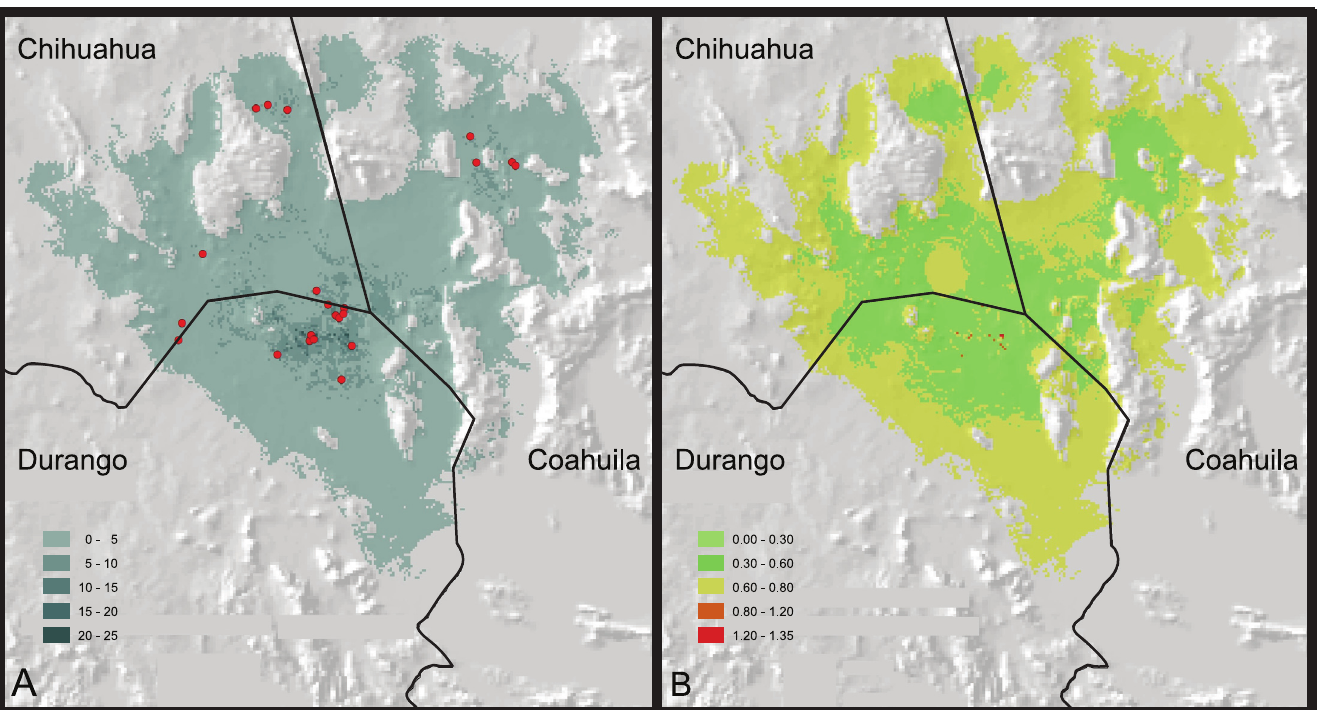
Fig 2. Maps showing the potential distribution and abundance of Gopherus flavomarginatus . (A) Inferred abundance for the Bolson tortoise (burrows/ Km 2 ); red dots pinpoint the sites where the abundance data for the Bolson tortoises was recorded. (B) Standard deviation of abundance.